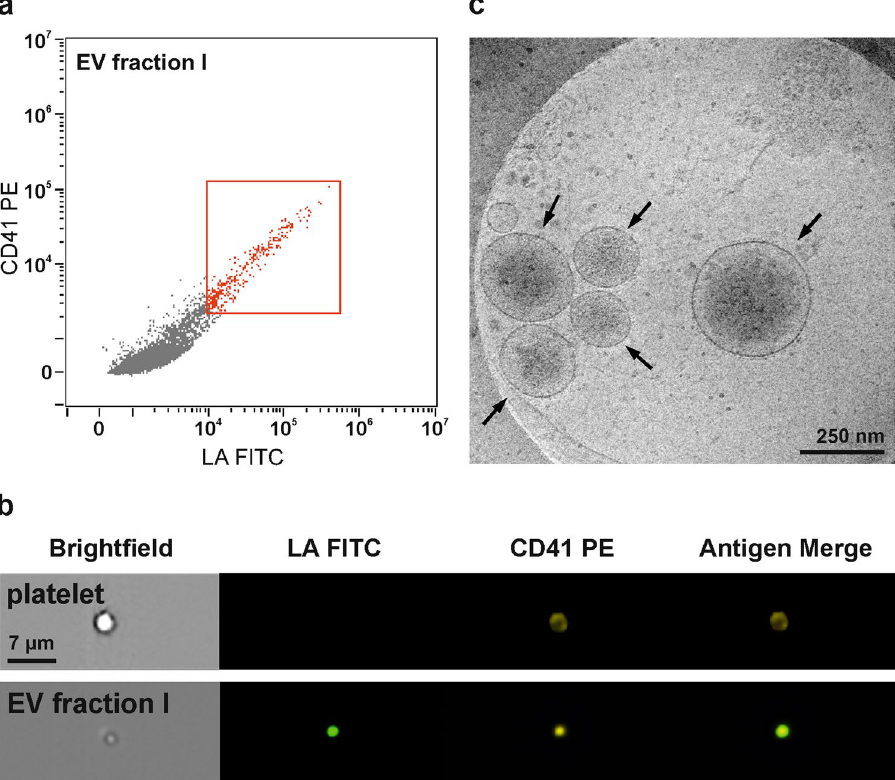
Figure 3. Visualization of platelet-derived EVs from EV fraction I. ( a ) EV fraction I was analyzed by imaging flow cytometry combining high speed multispectral image acquisition and automated image analysis. Phosphatidylserine exposing platelet-derived EVs were identified as lactadherin + (LA + ) and CD41 + events in the EV gate (red square) as described in the Methods section. ( b ) An image depicting a platelet (CD41 + ) is shown in comparison to an image of an EV from fraction I (LA + CD41 + ). ( c ) Cryo-electron micrographs of EV fraction I showing the presence of round, membrane-bound vesicles (black arrows) in a size range of 85–550